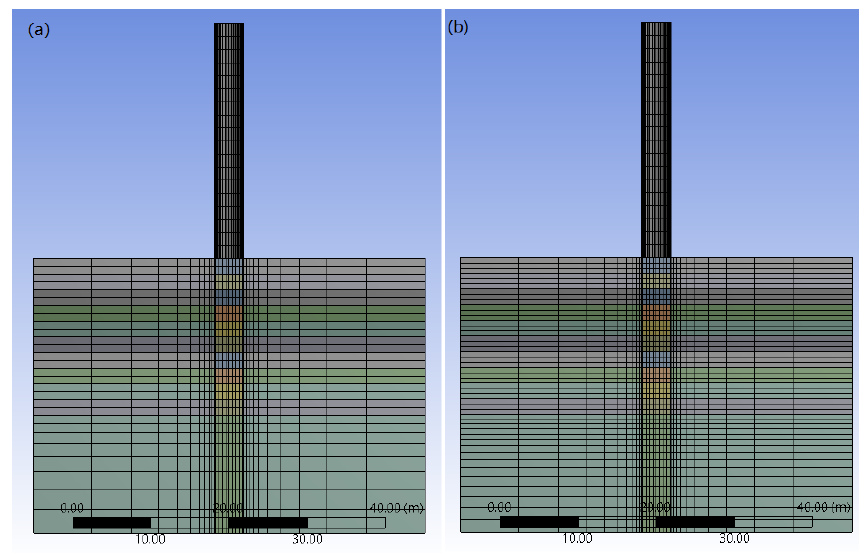
Figure 7. Mesh density, ( a ) 37,405 nodes model. ( b ) 56,932 nodes model.